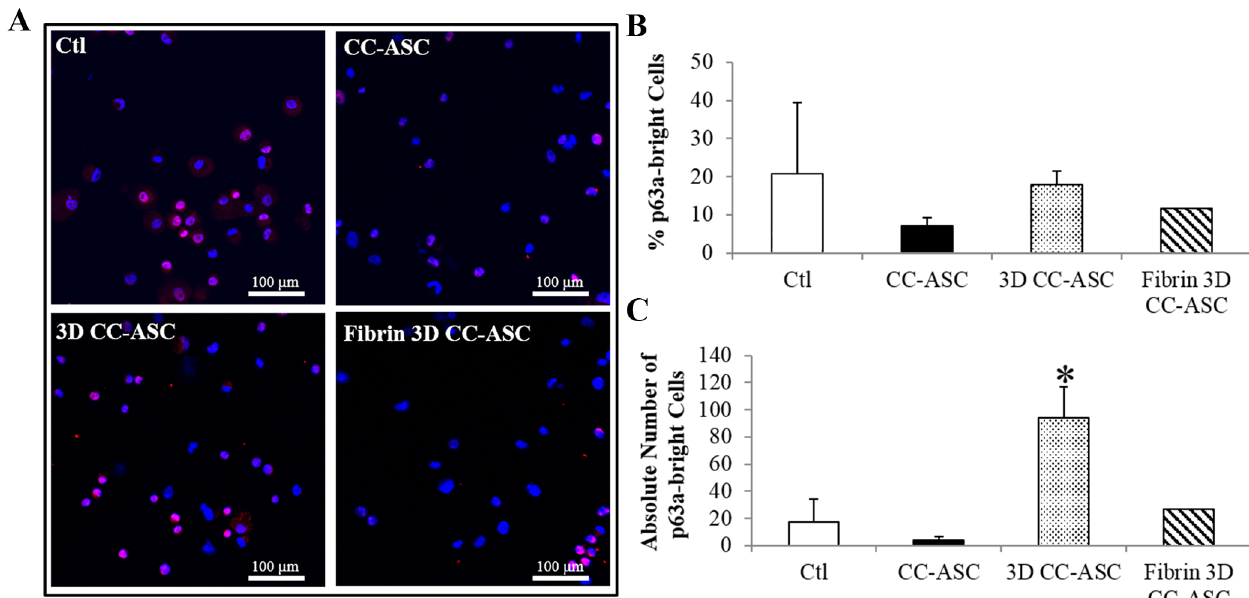
Fig 6. Expression of p63 α in cultured LEC cell clusters with ASCs evaluated by immunocytochemistry. (A) Representative images showingthe expressionof p63 α in cultured LECs. (B) The percentagesof p63 α -bright cells in cultured LECs. (C) The absolutenumbers of p63 α - bright cells in culturedLECs. The absolutenumber of p63 α -bright cells = the percentage of p63 α -bright cells x (number of cells harvested/number of cells seeded). * : p < 0.05in comparisonwith results of control. Ctl: control. CC-ASC: cell clusters of LECs cultured directly on ASCs. 3D CC-ASC: cell clusters of LECs cultured on ASCs using the 3D method. Fibrin 3D CC-ASC: cell clusters of LECs cultured on ASCs using the fibrin 3D method. Scale bar = 100 μ m.